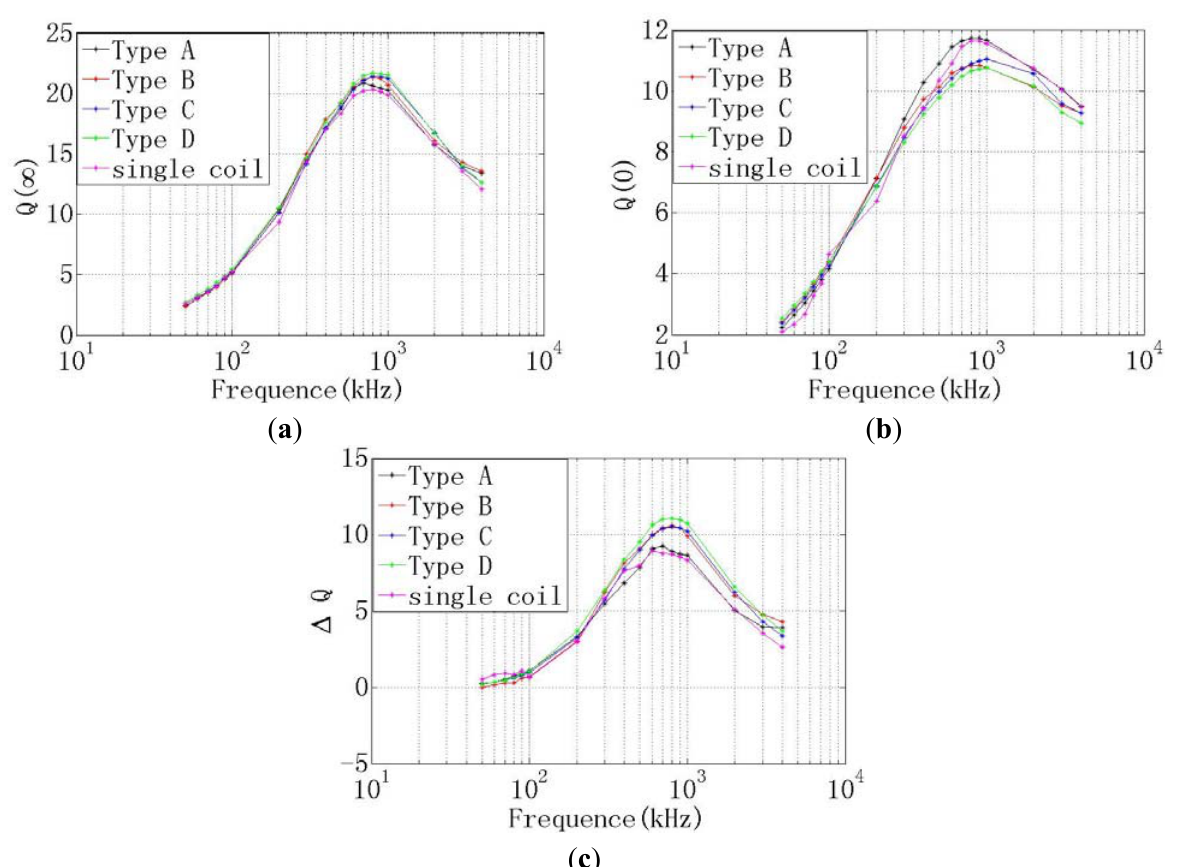
Figure 8. Comparison of the Q -factors of the four dual-coil probes and the single-coil probe ( a ) Q ( ∞ )- f curves of the different probes; ( b ) Q (0)- f curves of the different probes; ( c ) Δ Q - f curves of the different